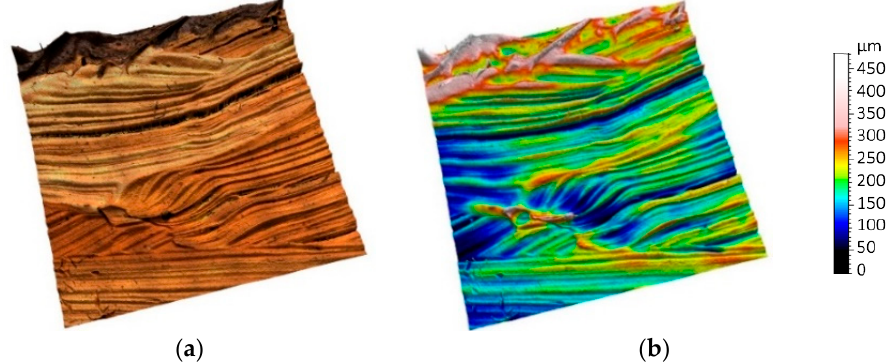
Figure 10. Topographic digital model of a millimeter scale region (10 × 10 mm)—focus variation measurements: ( a ) surface topography with image and ( b ) surface topographic map.